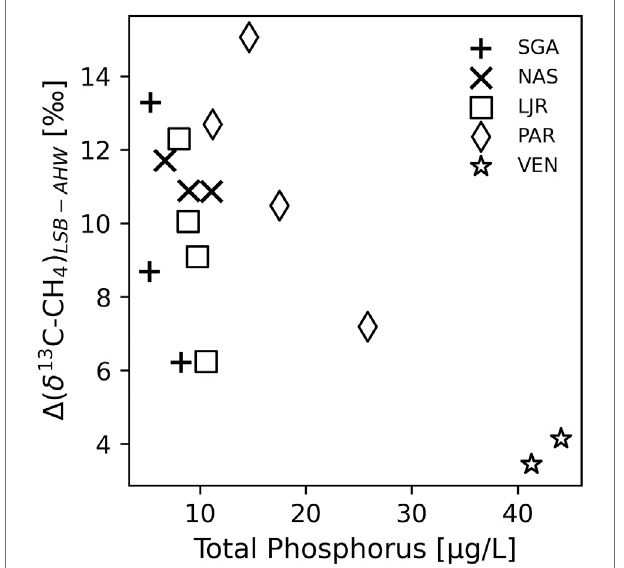
FIGURE 4 | Difference in δ 13 C-CH 4 between littoral sediment bubbles (LSB) and anoxic hypolimnion water (AHW) compared to total phosphorus concentration in surface water in the middle of each lake. Each point corresponds to 1 day when both δ 13 C-CH 4 and total phosphorus were sampled.